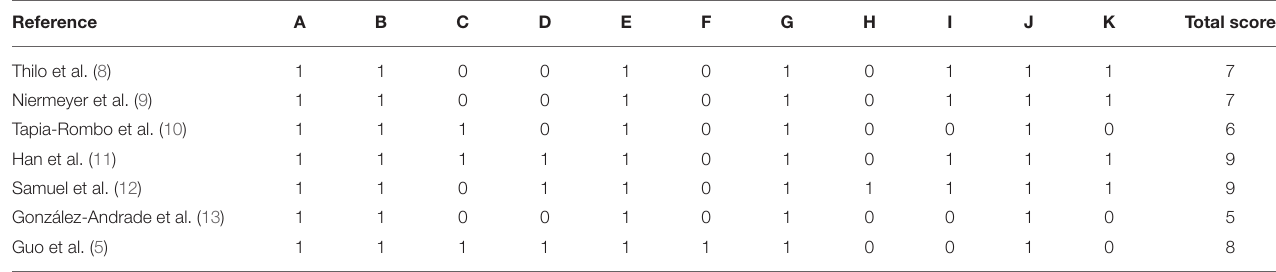
TABLE 2 | Quality assessment of studies by the Agency for Healthcare Research and Quality (AHRQ) scoring system.